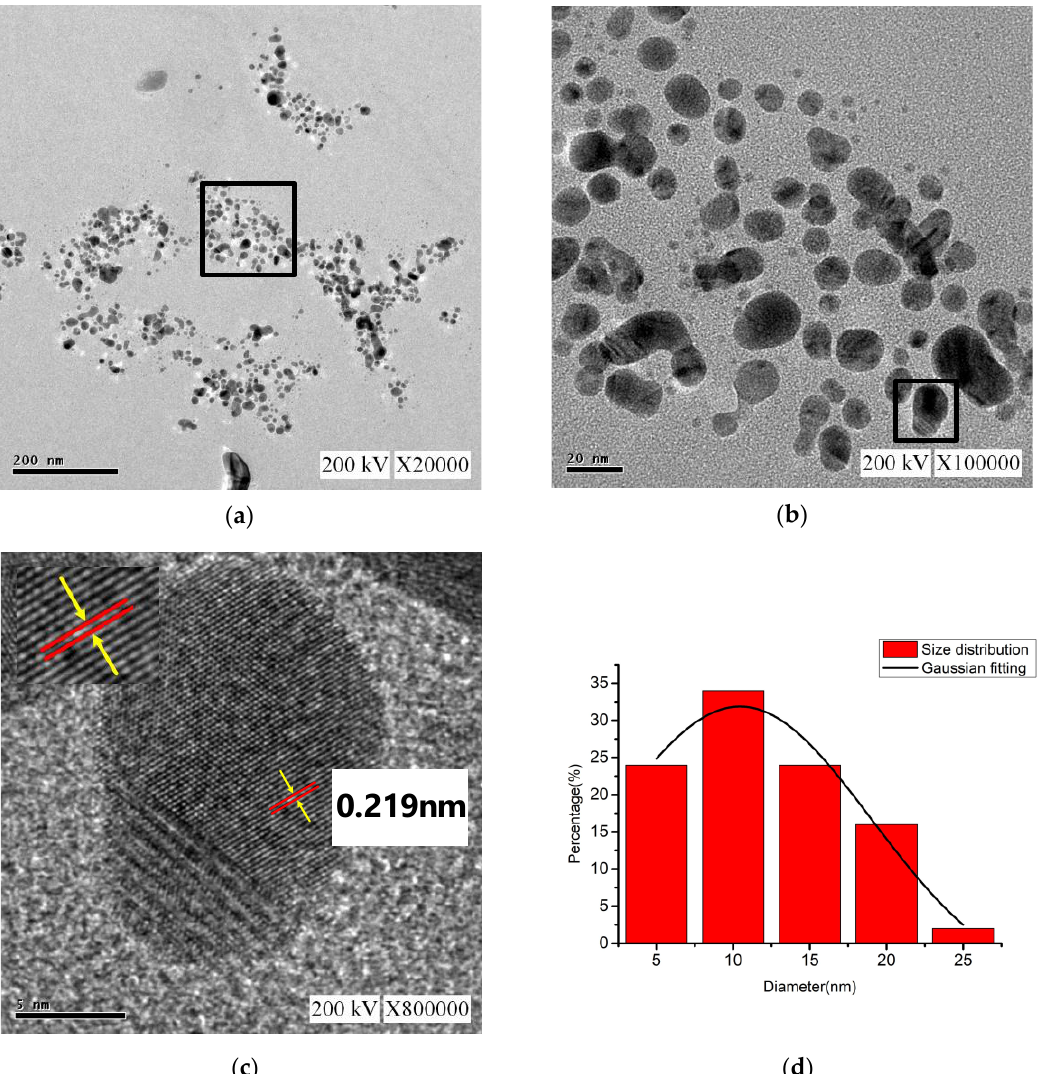
Figure 12. Nano-Ag TEM images: ( a ) 200 nm; ( b ) 20 nm; ( c ) 5 nm; and ( d ) size distribution.